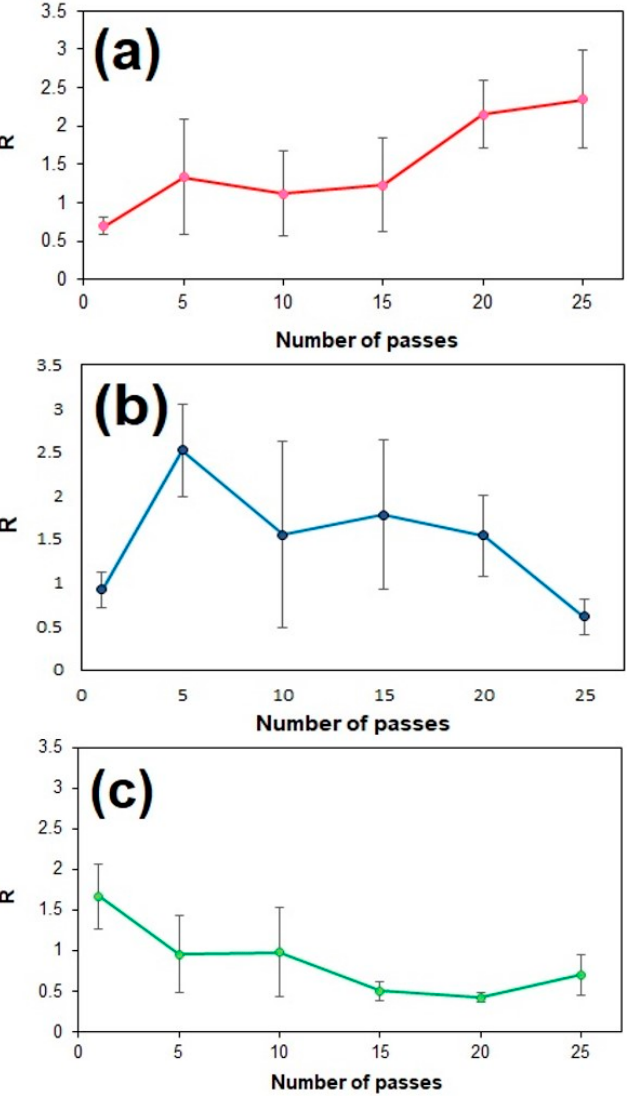
Figure 7. Enhancement ratio as a function of spray nozzle passes for different G-SERS substrates. ( a ) GO coated dendrites. ( b ) rGO-coated dendrites. ( c ) GNP-coated dendrites.